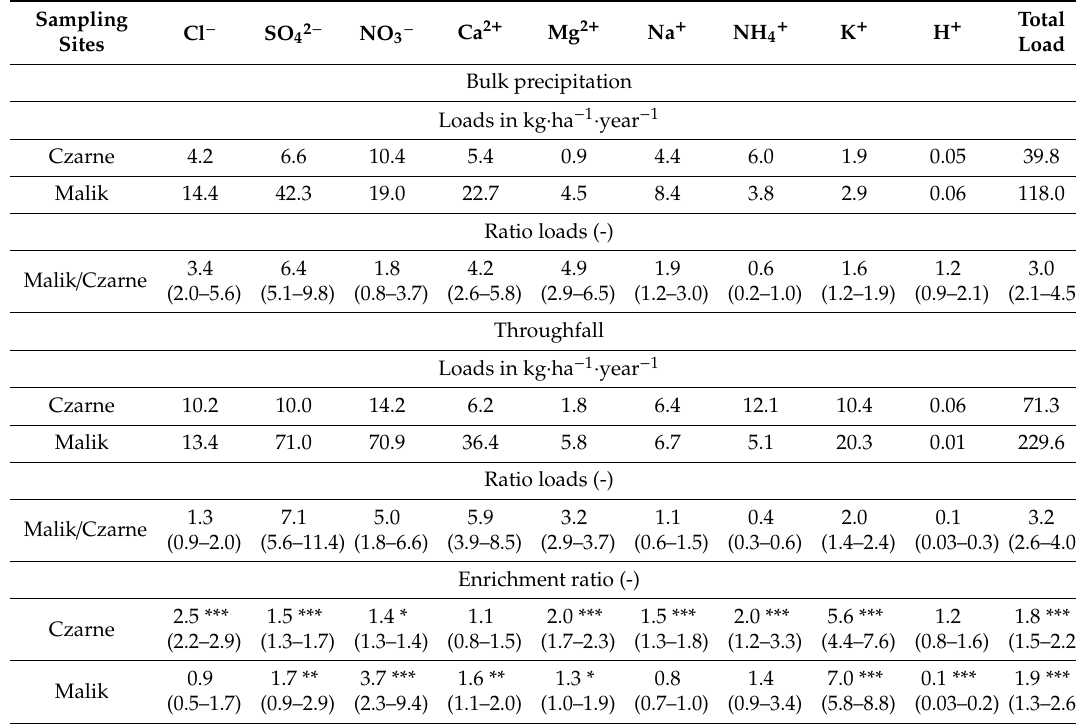
Table 5. Total element deposition, deposition ratios, and enrichment ratios (ER)—averages for the research period calculated on the basis of annual